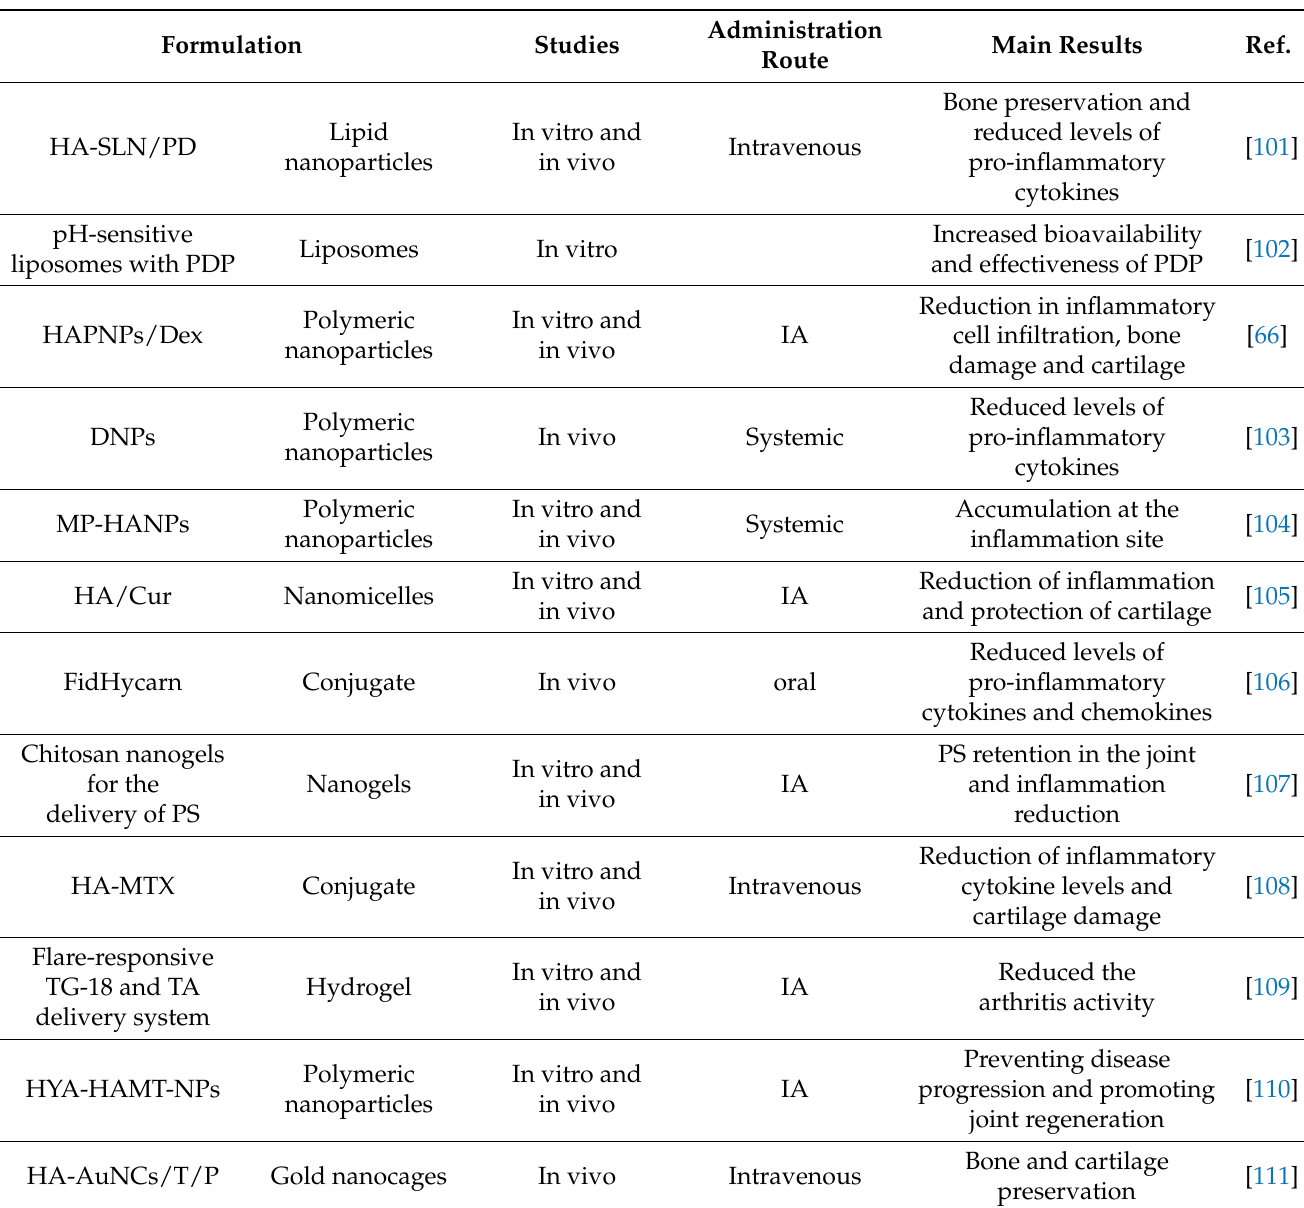
Table 2. Study summaries with HA, for the treatment of